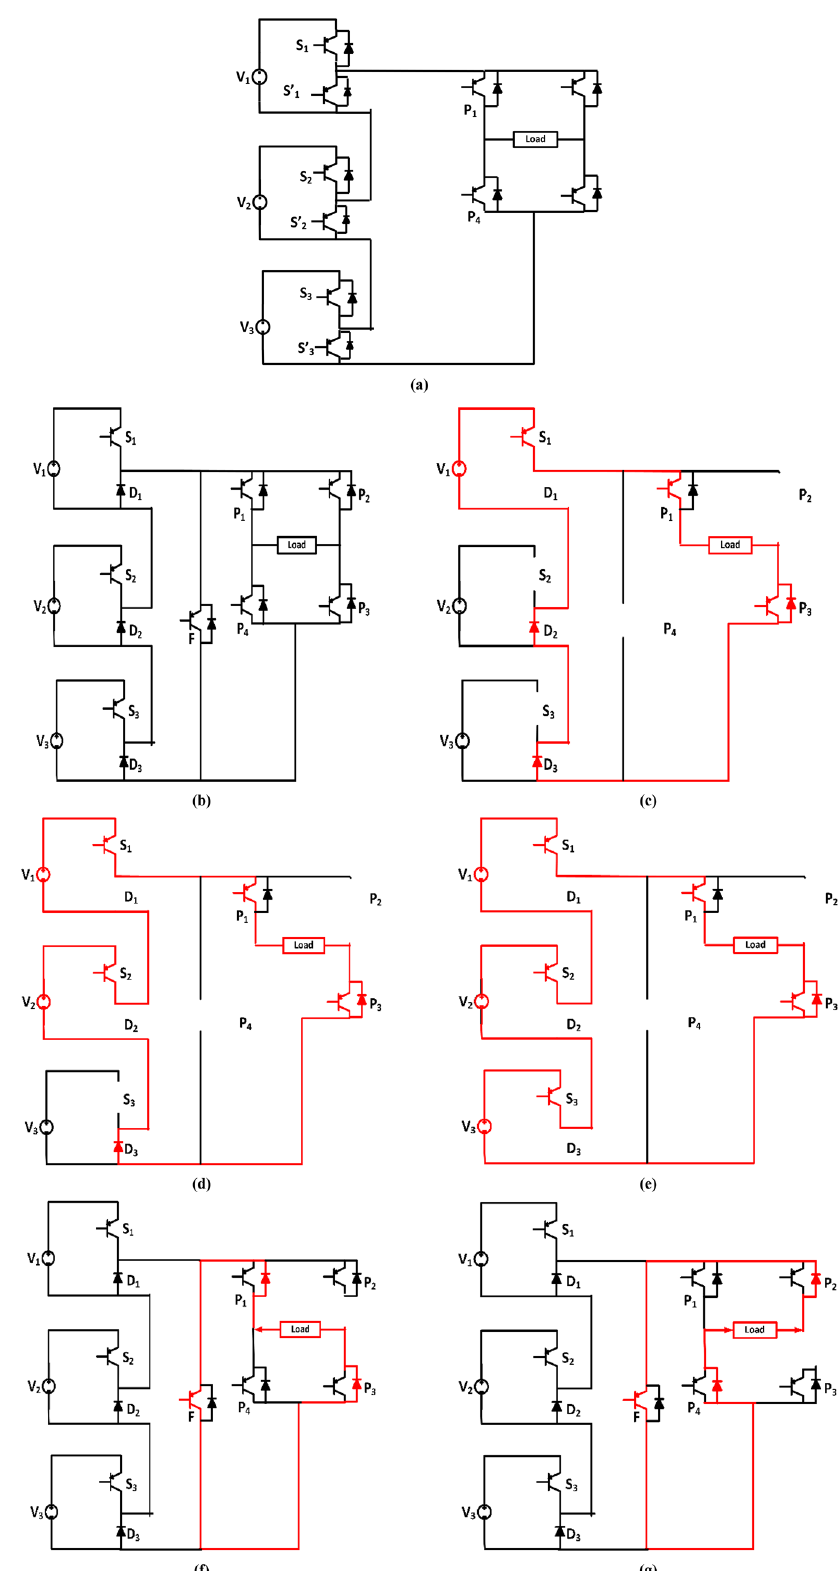
Fig. 2 a circuit diagram of Cascaded Half Bridge MLI with Polarity Changer b Circuit diagram of Modified cascaded half-bridge MLI with PC for seven levels c Flow of current in the circuit during + V d Flow 1 of current during + (V + V ) 1 2 e Flow of current dur- ing + (V + V + V ) f Flow of cur- 1 2 3 rent during 0 V and the current flowing through Diodes of P 1 and P g Flow of current in the 3 circuit during 0 V and the cur- rent flowing through diodes of P and P 2